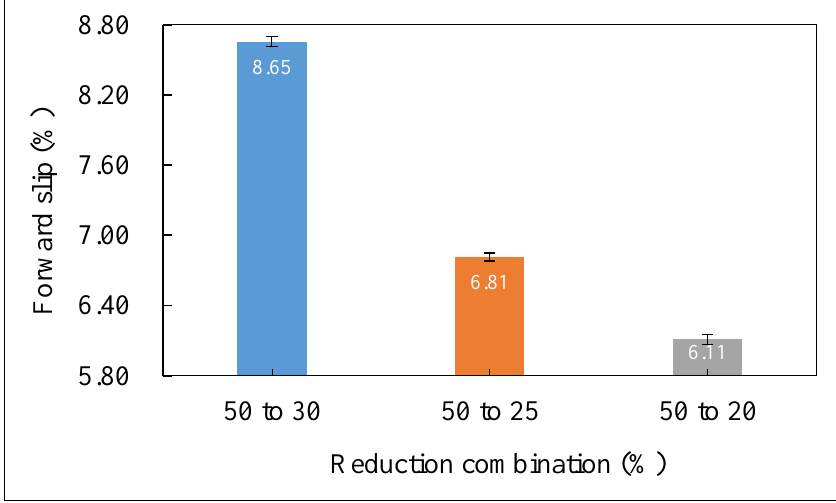
Figure 6. Forward slip versus reduction for the rolling phase with thicker thickness.